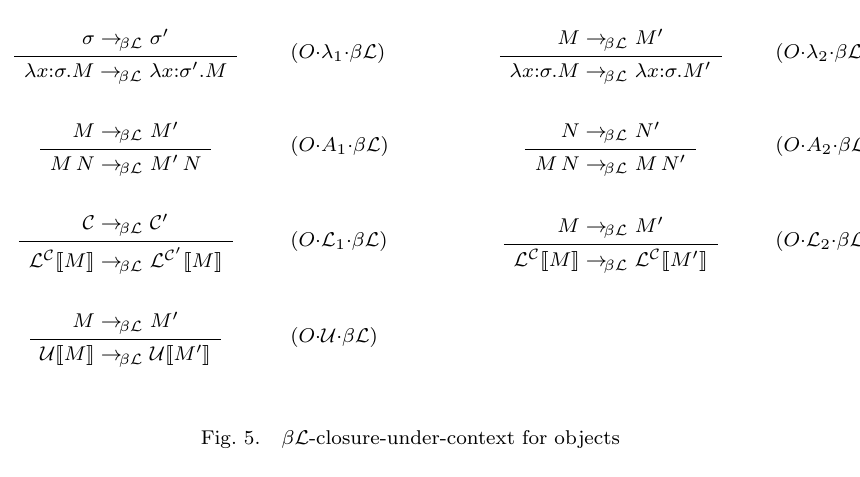
Fig. 5. β L -closure-under-context for objects